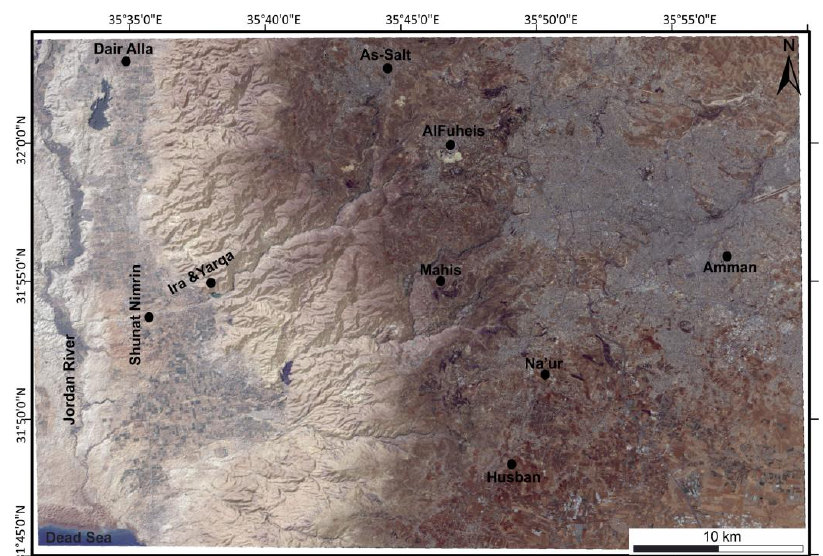
Figure 4. True-color composite (Bands 4, 3, and 2 in R, G, and B) of Landsat-8 OLI view of the study area on 10 June 2019. The image data were provided courtesy of the USGS (http://earthexplorer.usgs.gov).